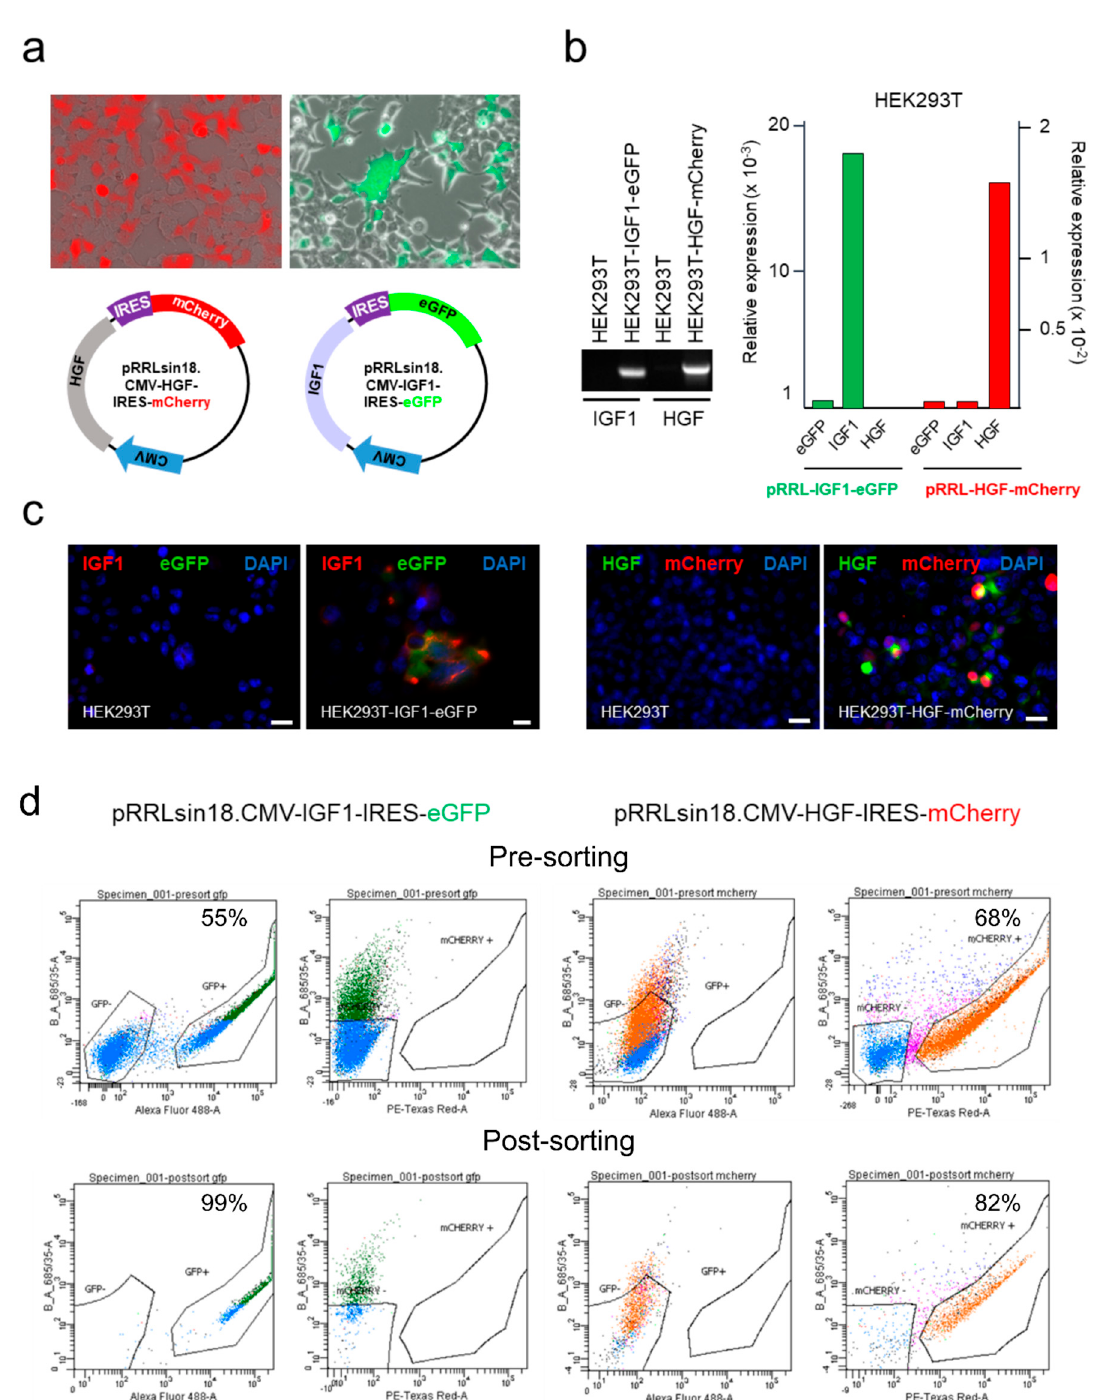
Figure 3. Lentiviral transduction of pCPC for IGF − 1 and HGF overexpression. ( a ) Microscopy images at 200 × magnification of transiently transfected HEK293T and schematic representation of the lentiviral vectors pRRLsin18.CMV-HGF-IRES- mCherry and pRRLsin18.CMV-IGF1-IRES-eGFP. ( b ) Overexpression analysis of IGF − 1 and HGF by RT − qPCR in HEK293T cells transfected with IGF-1/eGFP and HGF/mCherry. Non-transfected cells were used as negative control. ( c ) Immunofluorescence (IF) analysis of transfected HEK293T co-expressing IGF1/eGFP or HGF/mCherry. Scale bar represents 20 µ m. ( d ) Cytometric analysis of IGF1/eGFP and HGF/mCherry transduced pCPC confirming cell enrichment post-sorting.